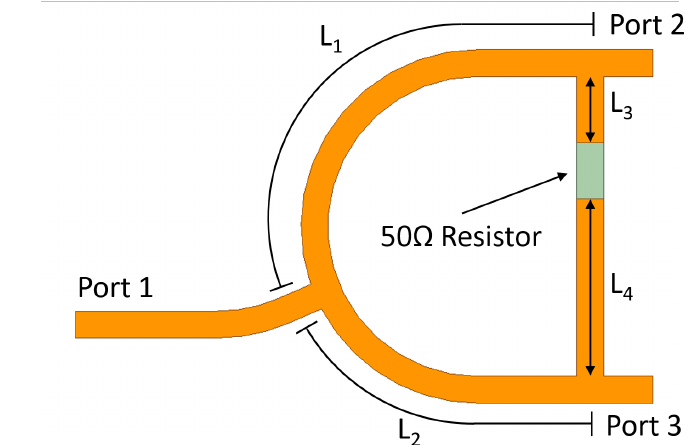
Figure 14. Layout of unequal power